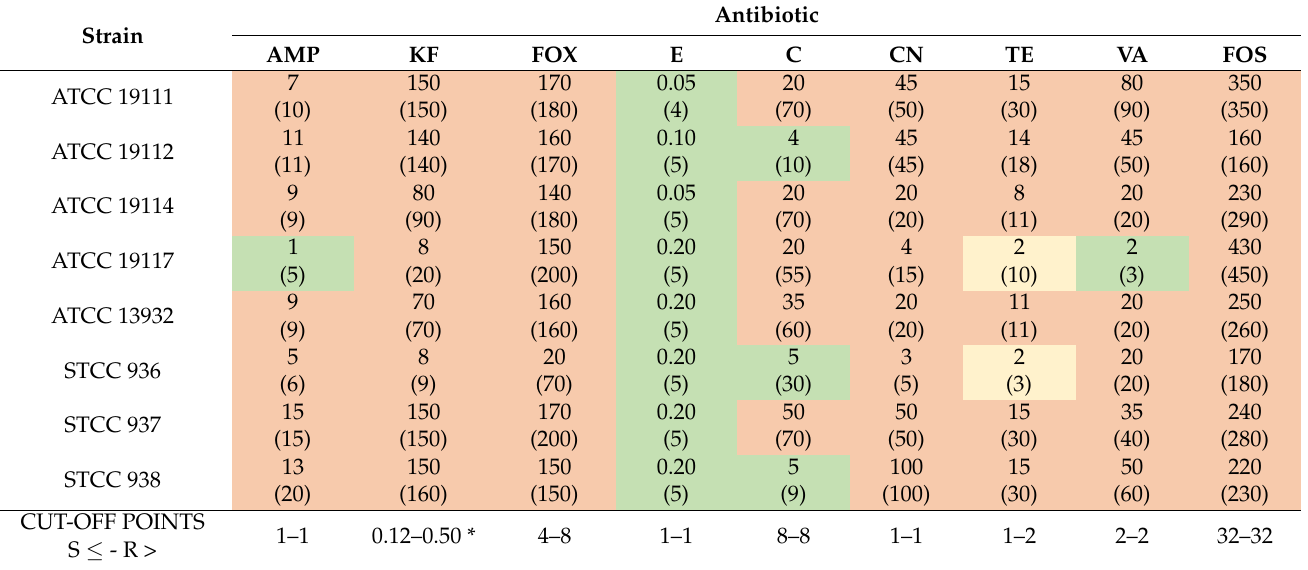
Table 3. Minimum inhibitory concentration (MIC; ppm) and minimum bactericidal concentration (MBC; ppm) for nine antibiotics of clinical interest on eight strains of Listeria monocytogenes .